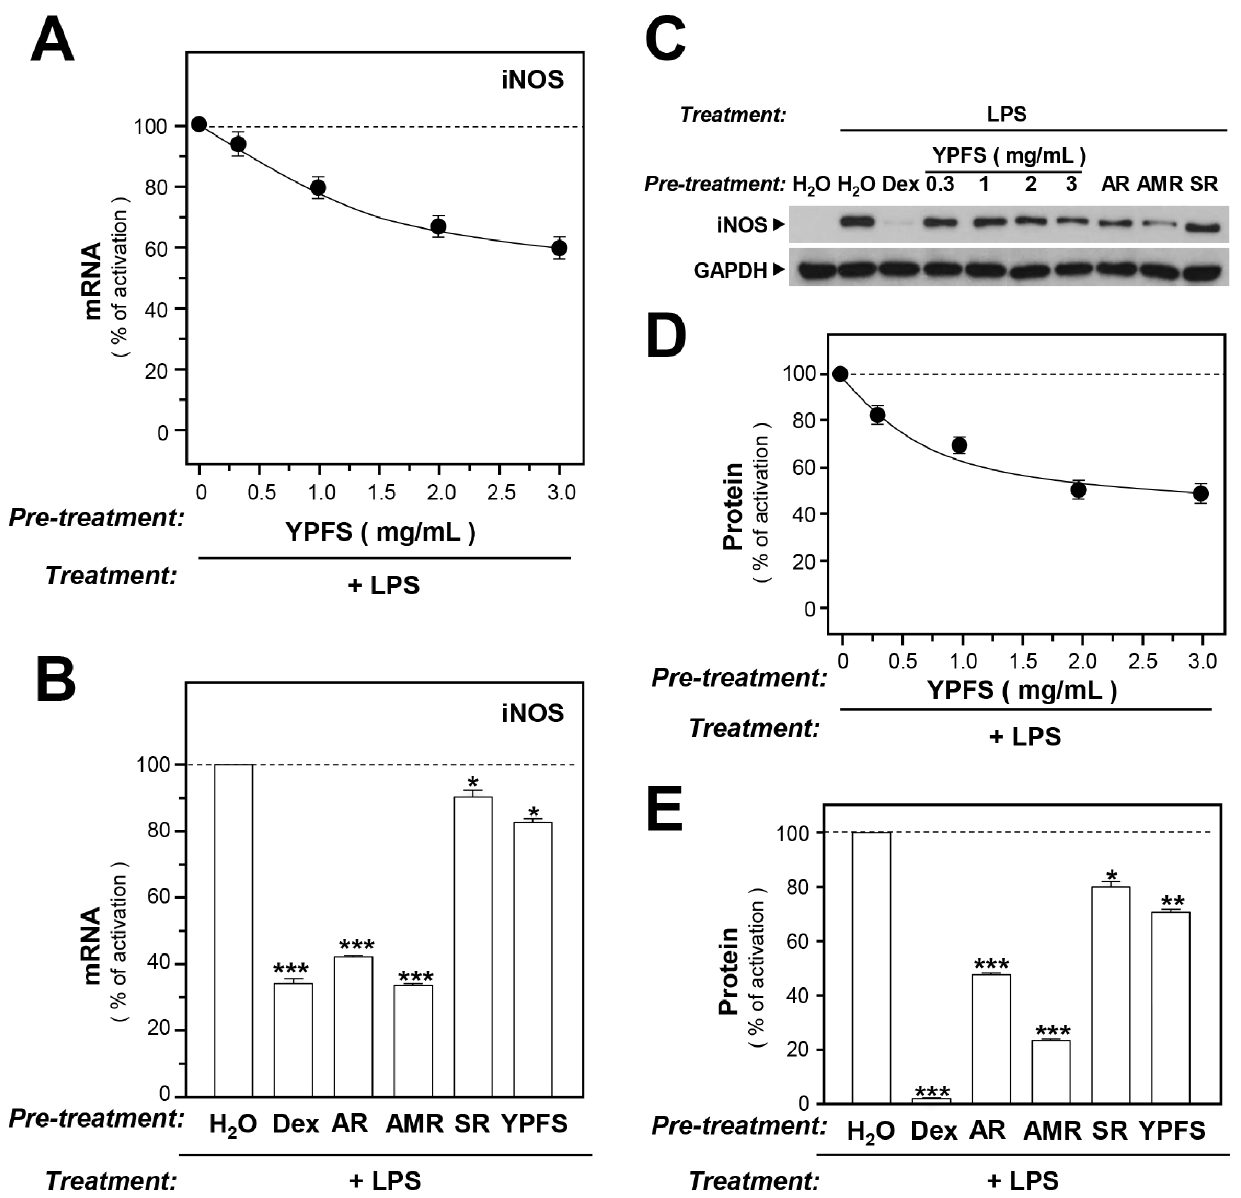
Figure 1. YPFS suppresses LPS-induced expression of iNOS in cultured macrophages. Cultured macrophages were treated with herbal extracts for 3 hours, after which LPS (1 m g/mL) was applied to the cultures for 24 hours to mimic chronic inflammation. Here, 10 m M dexamethasone (Dex) served as a positive control. The levels of mRNAs encoding iNOS were determined using real-time PCR (RT-PCR), performed with GAPDH serving as an internal control for normalization. The expression of iNOS protein was examined using western-blotting analysis. Whole cell lysates of macrophages were collected and equal amounts of total protein were loaded on gels and stained with an anti-iNOS antibody. ( A ): Inhibition of iNOS mRNA expression by YPFS in LPS-stimulated RAW264.7 cells. ( B ): Inhibition of iNOS mRNA expression by single herbs in LPS-stimulated RAW264.7 cells; 1 mg/mL of each of the herbal extracts was added to macrophages and the expression level of iNOS mRNA was determined using RT-PCR. ( C ): Western blots showing iNOS staining. ( D ): Inhibition of iNOS protein expression by YPFS in LPS-stimulated RAW264.7 cells. ( E ): Inhibition of iNOS protein expression by individual herbs in LPS-stimulated RAW264.7 cells. Single herbal extracts were added to LPS-stimulated macrophages for 24 hours. Results in (D) and (E) were calculated using the western blots shown in (C). Values are expressed as % LPS-induced activation; mean 6 SD are shown, n= 4, each with triplicate samples. * p , 0.05; ** p , 0.01; *** p , 0.001.